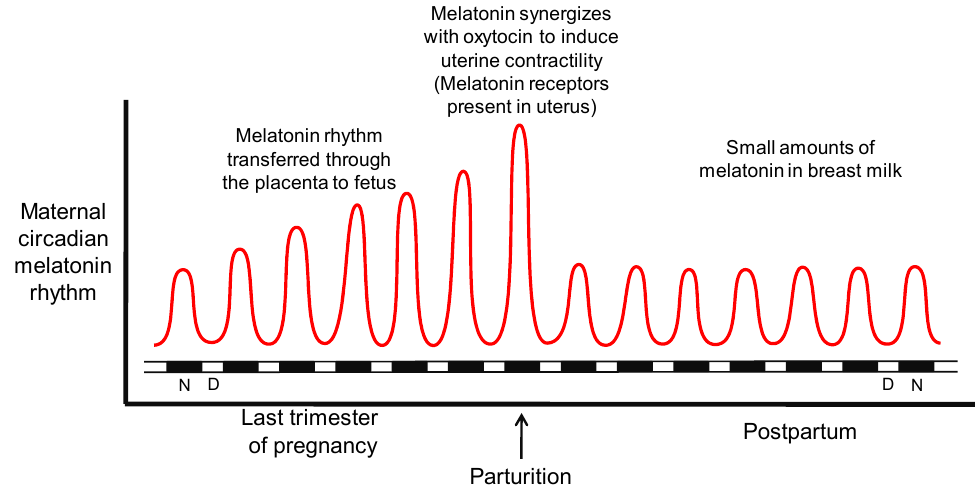
Figure 9. Diagrammatic representation of the circadian melatonin rhythm in human females during the last trimester of pregnancy and after delivery. The nocturnal melatonin peak gradually increases near term pregnancy. The augmented melatonin levels seem to aid in inducing uterine contractions at parturition since it has been shown to synergize with the released oxytocin to cause stronger uterine contractions. Shortly after delivery of the fetus, the nocturnal melatonin peak returns to its pre-pregnancy